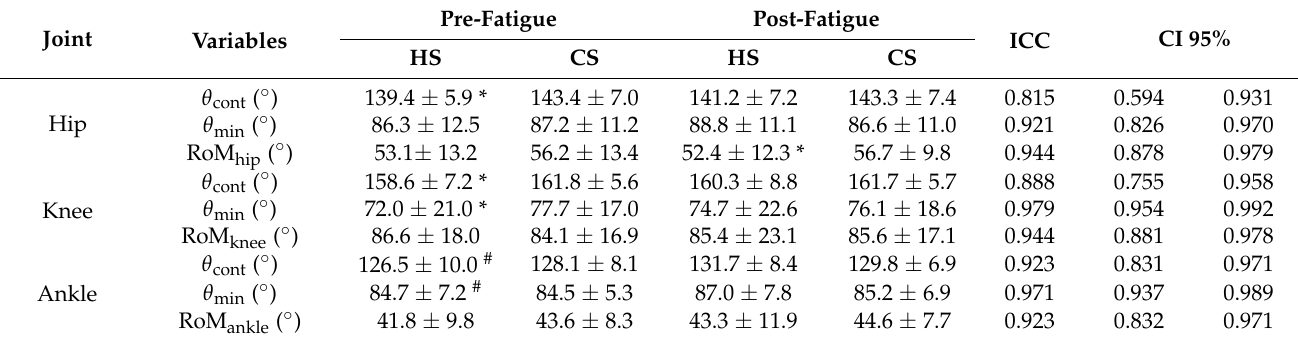
Table 2. Contact angle ( θ cont ), minimum angle ( θ min ) and RoM of hip, knee and ankle joints based on shoe conditions in pre-fatigue and